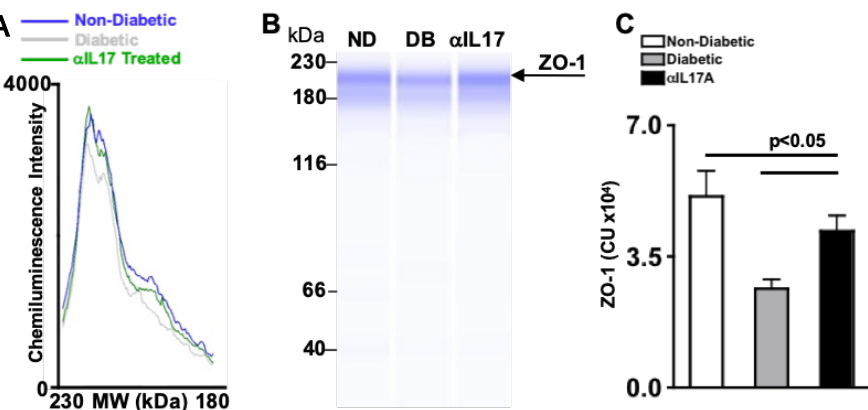
Figure 6. ZO-1 Degradation in anti-IL-17A Treated db/db Mice 2 Months Post-Diabetes. ( A ) Elec- tropherogram of ZO-1 in retinal protein lysates of non-diabetic, untreated db/db diabetic, and anti-IL-17A treated db/db diabetic mice. ( B ) Representative Wes gel, and ( C ) protein quantification of ZO-1 in retinal protein lysates of non-diabetic (ND), untreated db/db diabetic (DB), and db/db diabetic mice treated with 50 µ g/mL of anti-IL-17A; 2 months post-diabetes. Error bars represent the SEM. All p-values were equated using 2-way ANOVA and then unpaired student’s t -test with Tukey’s post-hoc analysis. Data are representative of three separate Wes analyses from with similar results.